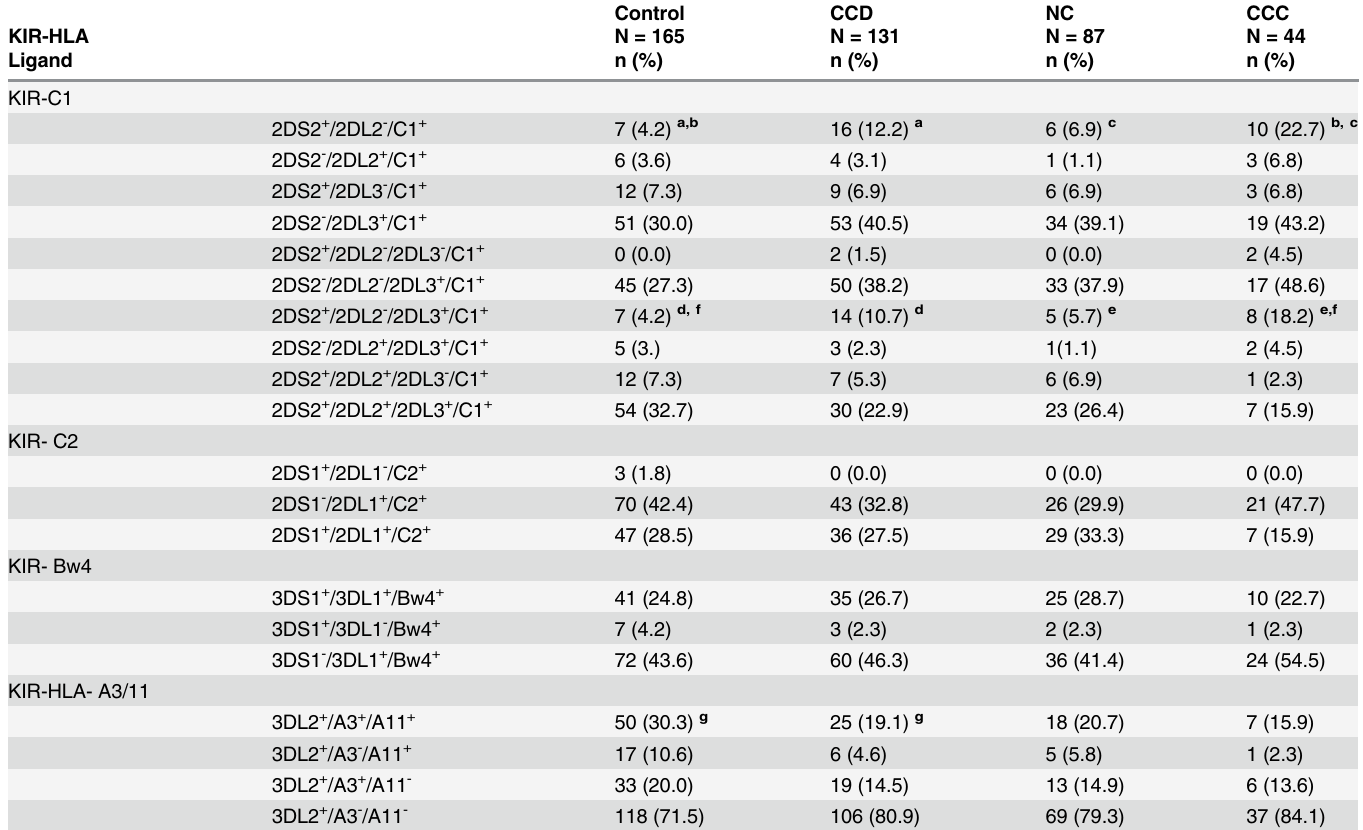
Table 4. Distribution of activating KIR plus inhibitory KIR and their respective ligands in chronic Chagas disease and controls. Control